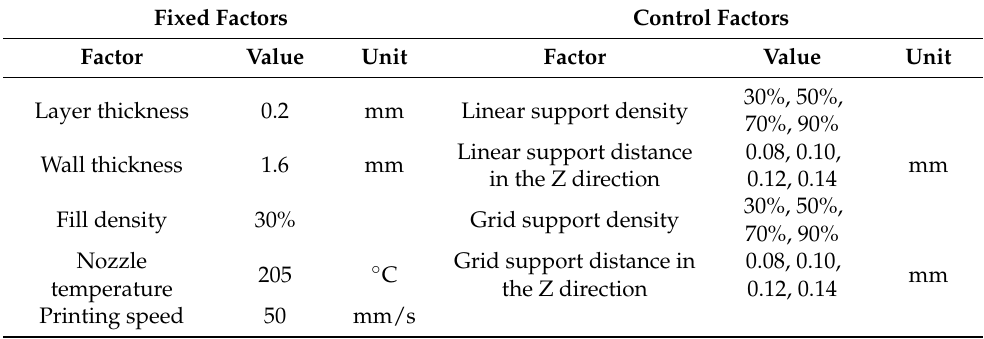
Table 1. 3D printing—list of other fixed